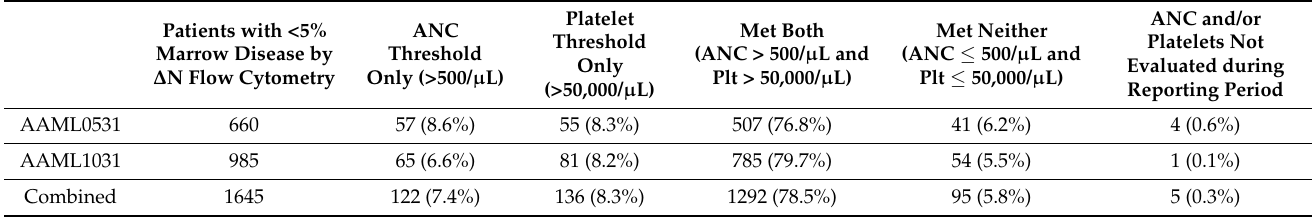
Table abbreviations: ANC, absolute neutrophil count; ∆ N, difference from normal; Plt, platelet. In a cumulative incidence of count recovery analysis, 96.2% and 98.1% of patients recovered ANC ≥ 500 cells/ µ L or platelet counts ≥ 50,000 cells/ µ L across the two Phase 3 COG trials at 42 and 49 days from the start of induction therapy, respectively. Only 86.3% and 92.4% reported recovery of both ANC ≥ 500 cells/ µ L and platelets ≥ 50,000 cells/ µ L patient characteristics by count recovery group can be found in Supplemental Table